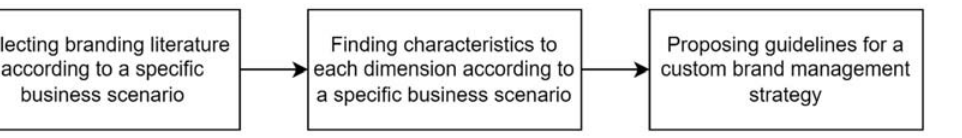
Figure 4. Example of application of the framework for proposing guidelines for a custom brand management strategy.